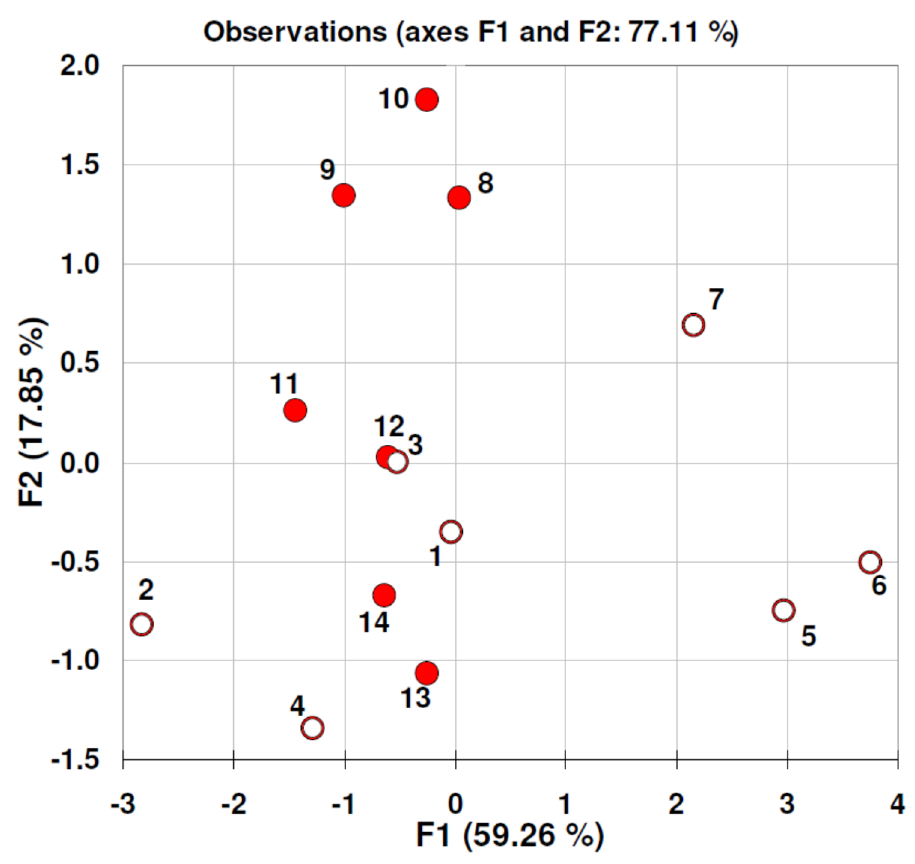
Figure 5. Factor scores plot (principal component analysis) related to 24 h experiment and calculated from data matrix consisting of Brilliant Blue concentrations at different times of experiment duration (variables) and different additives (objects) listed in Table 2. Object labels (circles correspond to samples without activated sludge addition): water BLANK (1), water and graphene oxide GO (2), water and β -cyclodextrin CD (3), water and raw dandelion pappus DP (4), water and microcrystalline cellulose MC (5), water and raw pine pollen PP (6), water and Egyptian Blue mineral pigments EB2 (7), activated sludge AS BLANK (8), activated sludge and graphene oxide GO (9), activated sludge and β -cyclodextrin CD (10), activated sludge and raw dandelion pappus DP (11), activated sludge and microcrystalline cellulose MC (12), activated sludge and raw pine pollen PP (13), activated sludge and Egyptian Blue mineral pigments EB2 (14).